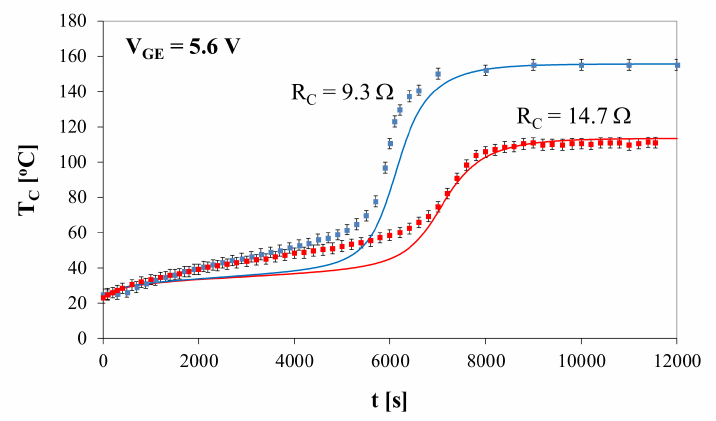
Figure 7. Measured and calculated waveforms of the case temperature of the